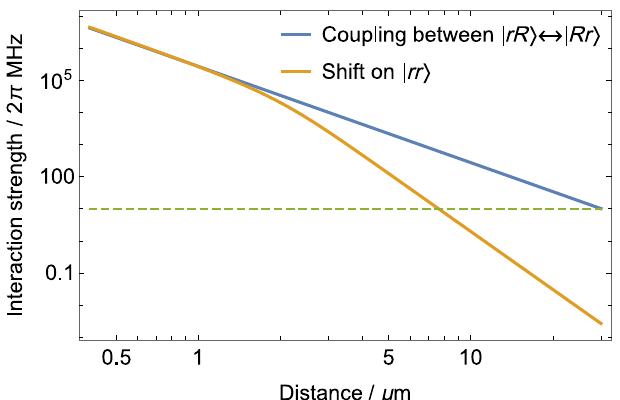
FIG. 7. Interactions between atoms as a function of the dis- tance between them. The green dashed line marks the interaction between the atom and the molecule at a separation of 0.6 μ m. The Rydberg states are the ones used in our example of CaF interacting with